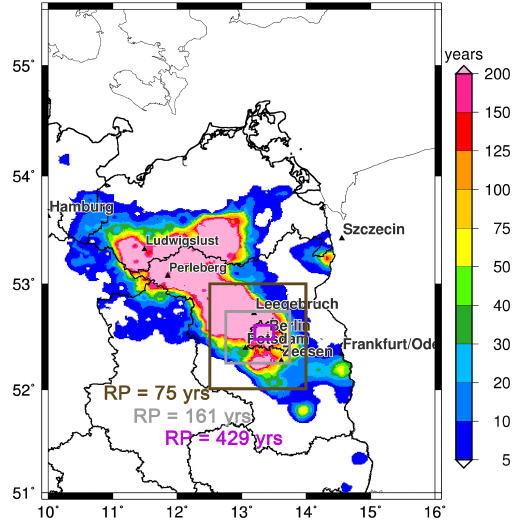
REGNIE using a Gumbel distribution (extreme value type 1; refer- ence period: 1951–2020). Note: all return periods above 200 years are shown uniformly in one colour due to statistical uncertainty (see text for more information). Coloured polygons (in pink, grey, brown) including the associated averaged return periods (RP) indi- cate three different-sized averaging areas explained in Table S2 and in the